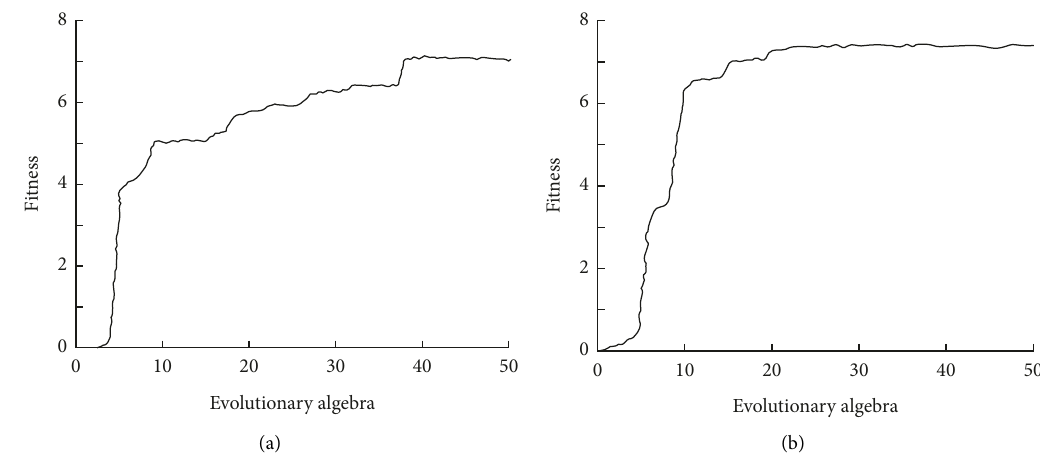
Figure 4: Evolution process of genetic algorithm population: (a) traditional GA population and (b) fuzzy GA population.